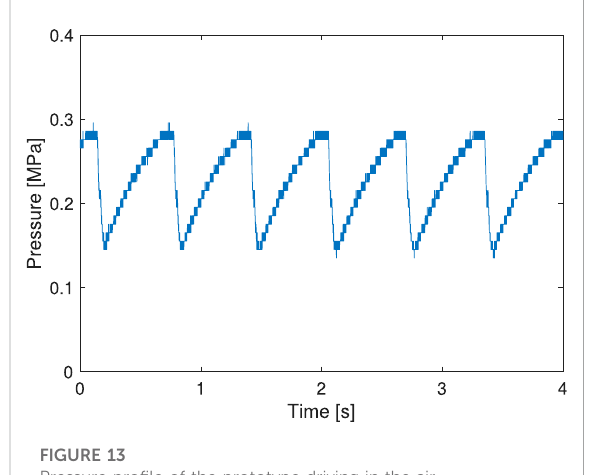
FIGURE 13 Pressure pro fi le of the prototype driving in the air.